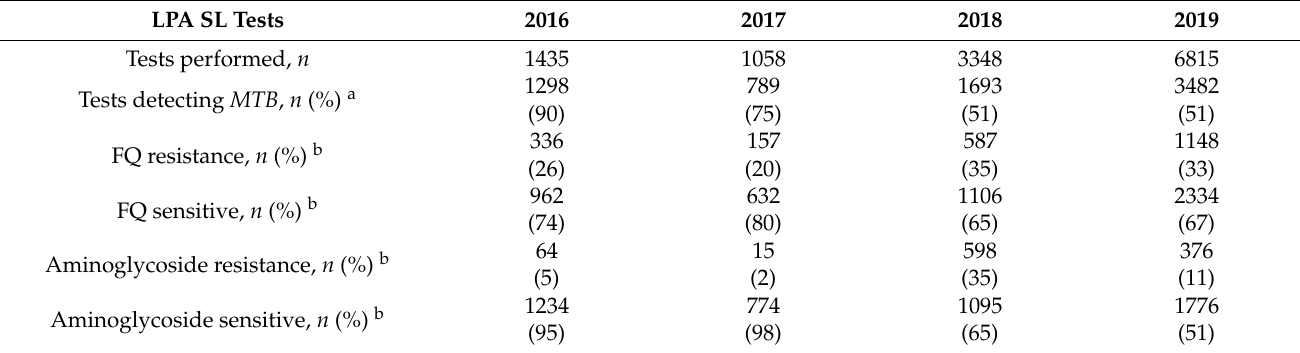
Table 4. Performance and results of second-line LPAs in Uzbekistan from 2012 to